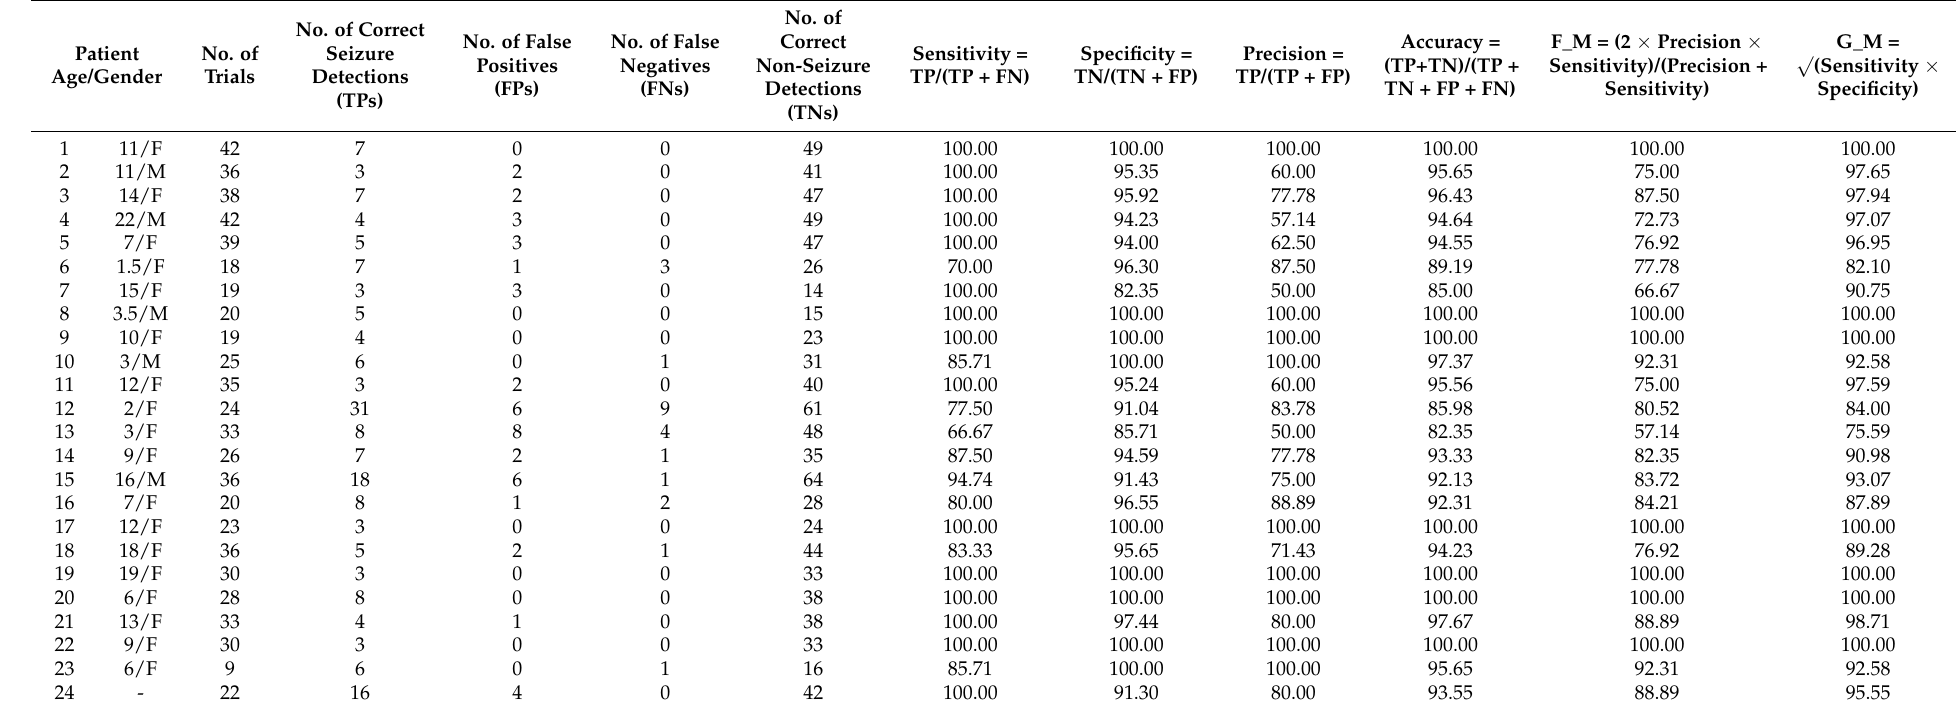
Table 3. Algorithm test results for the whole CHB MIT EEG